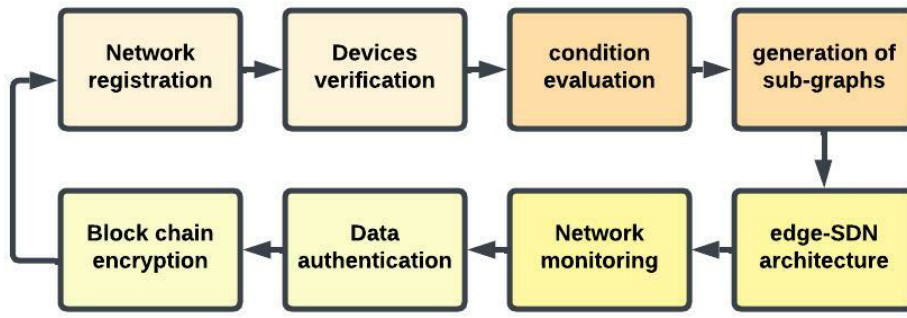
Figure 1. States of the proposed system with their interactions.